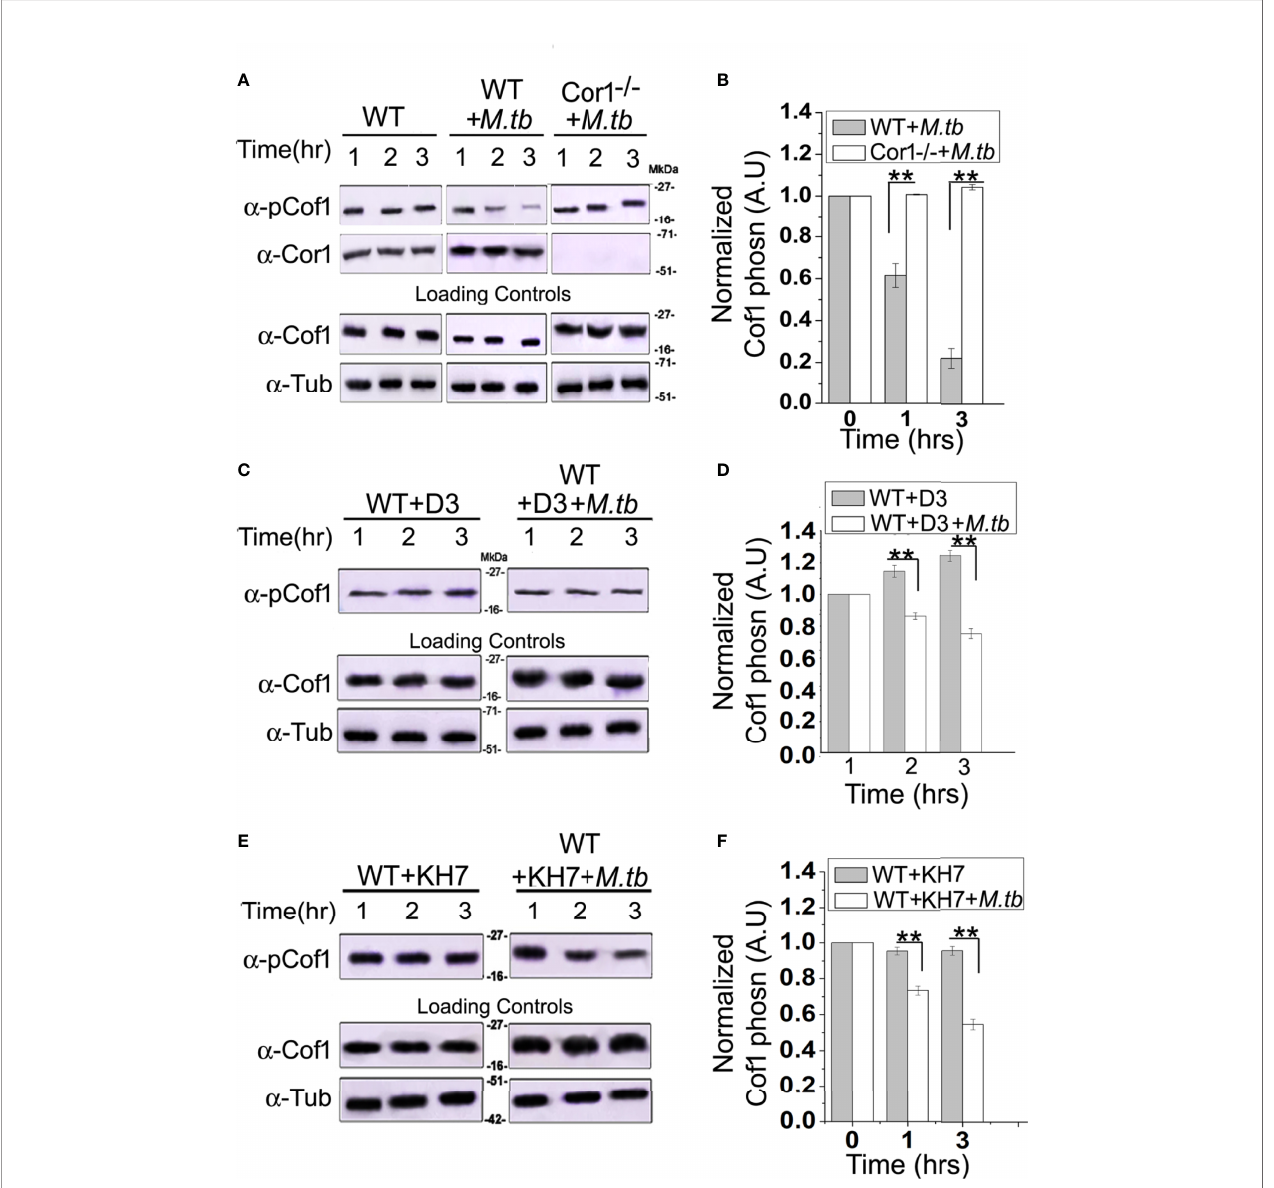
FIGURE 4 | Immunoblot analysis (A, C, E) and its corresponding densitometric analysis (B, D, F) for Co fi lin1 phosphorylation that were carried out in (A) untreated and uninfected BMDM (left panel), (A, B) untreated but M. tb infected WT (middle panel) or Cor1 -/- (right panel) BMDM, (C, D) D3 pretreated (left panel) or D3 pretreated and M. tb infected (right panel), (E, F) KH7 pretreated (left panel) or KH7 pretreated and M. tb infected wild-type BMDM, respectively (n = 3). Infections were carried out at an MOI of 1:20 for indicated time points. Immunoblots of Co fi lin1 and b-tubulin served as loading control for these experiments. Data represents mean ± SEM; ** p <